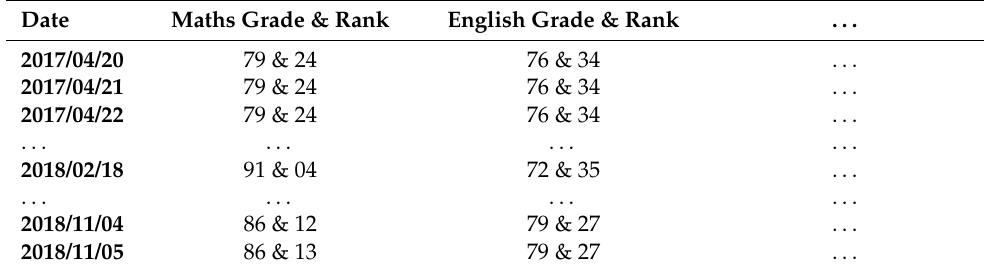
Table 4. Extended Examination Data of Student